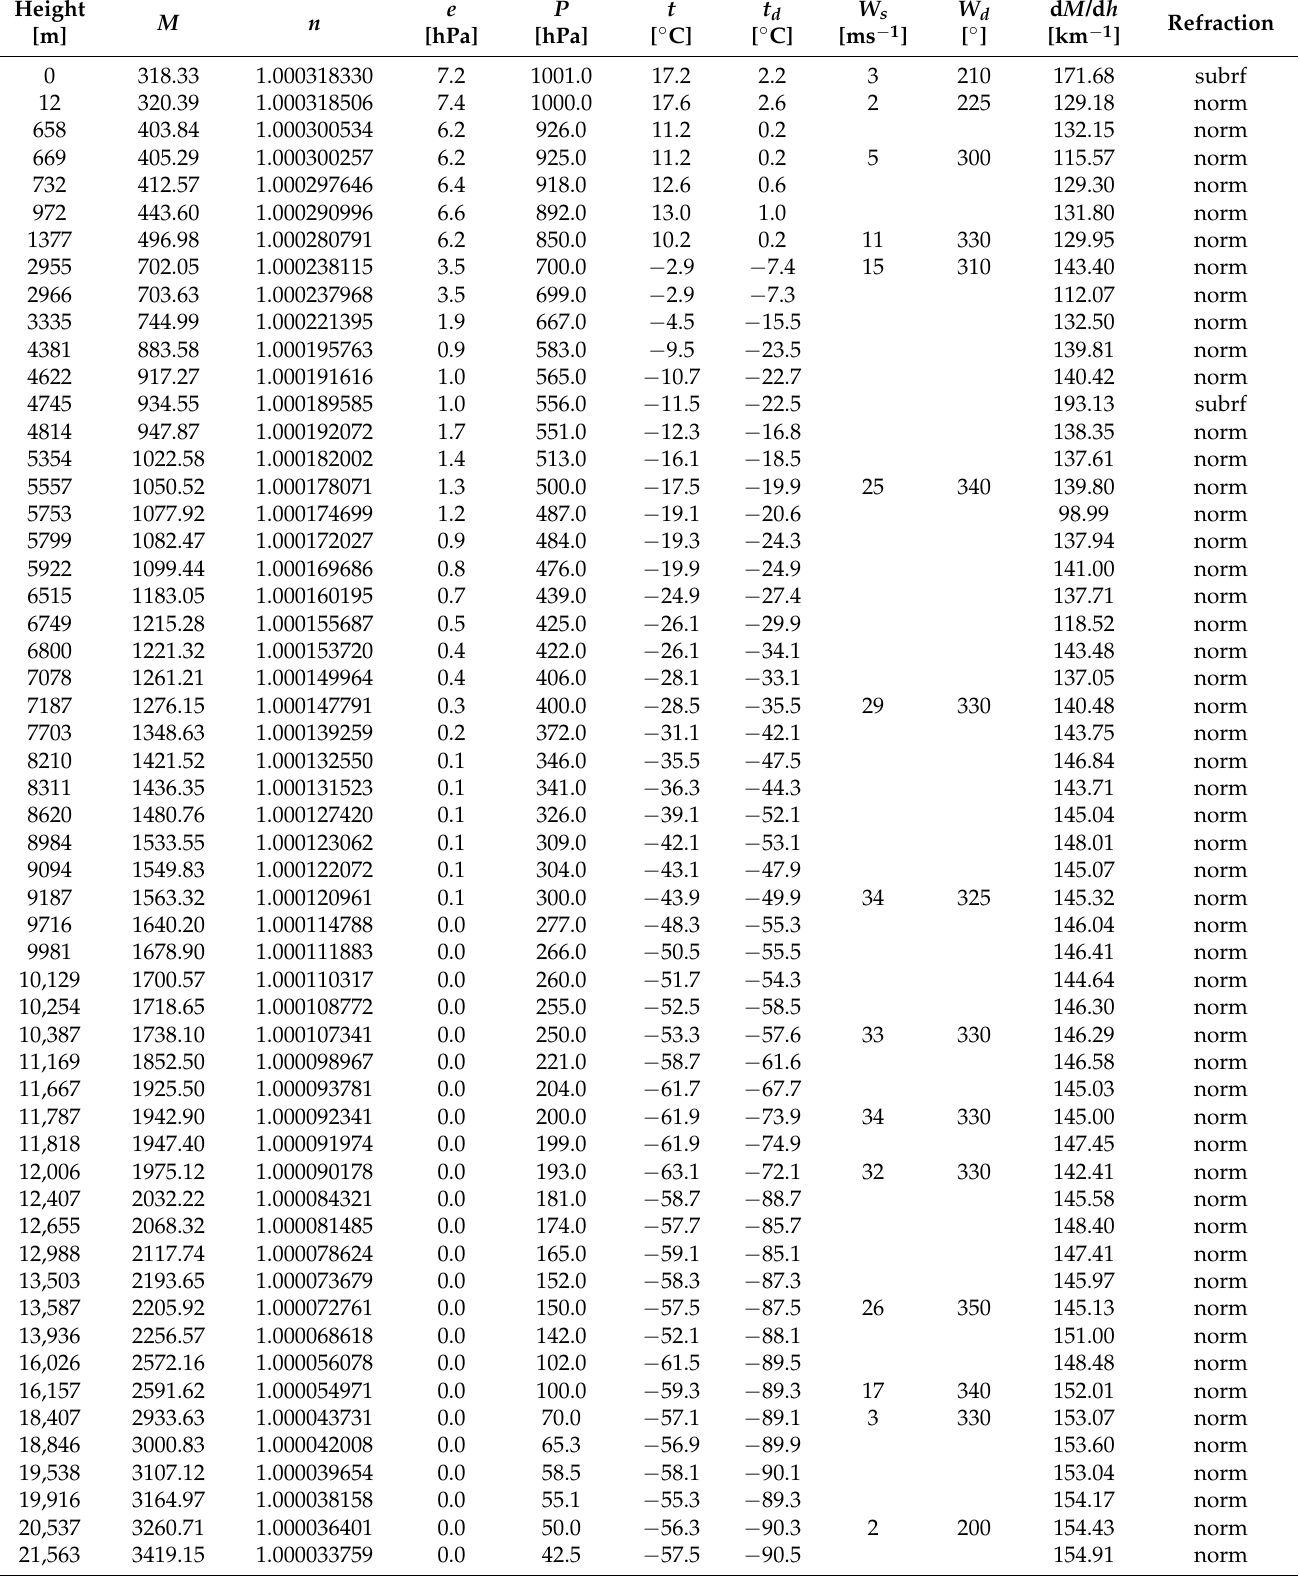
Table A3. Aerological soundings data and refractive profiles on 11 March 2020 at meteorological station Zagreb Maksimir (WMO index